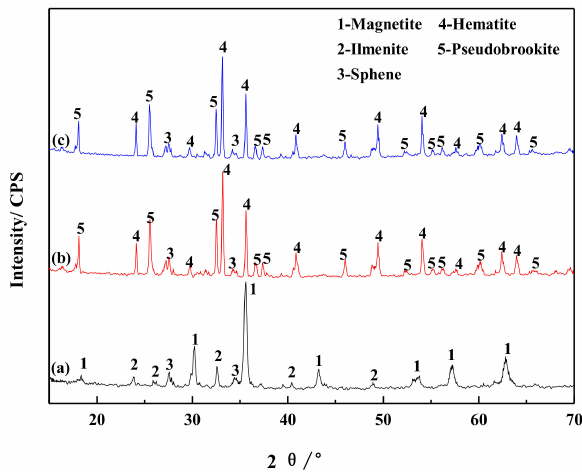
Figure 8. XRD patterns of different samples ( a ) concentrate; ( b ) single K 2 SO 4 roasting slag; ( c ) K 2 SO 4 /KCl roasting